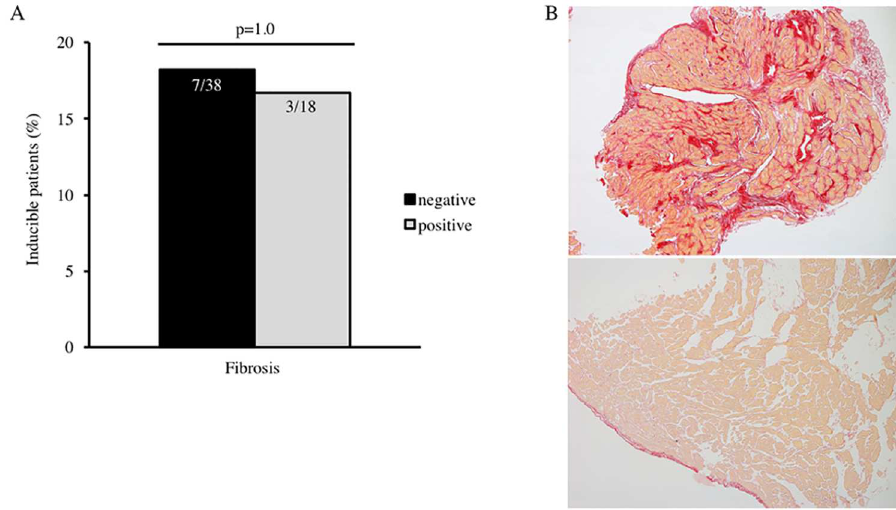
Fig 2. Association between ventricular inducibility and myocardial fibrosis detected in endomyocardial biopsy. A. There was no associationbetweenthe presenceand amount of myocardial fibrosis describedin histopathology and ventricular inducibility duringprogrammed ventricularstimulation (p = 1.00). B. The upper panel of Fig 2B illustrates an exampleof severe myocardialfibrosis in endomyocardial biopsy detected by picrosirius red staining in a patient with non-ischemic dilated cardiomyopathy and no inducibleventricular arrhythmias. The lower panel depicts the histologyof healthy myocardiumwith a fibrosis area of <